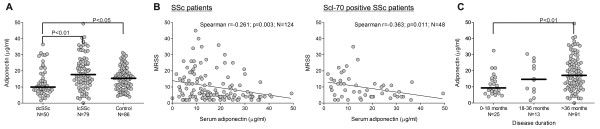
Serum adiponectin levels in systemic sclerosis (SSc). Sera from 129 patients with limited (lcSSc) or diffuse (dcSSc) cutaneous SSc and 86 controls were analyzed by multiplex assays. (a) Horizontal bars indicate median values in each group. (b) Correlation between adiponectin levels and modified Rodnan skin score (MRSS) in all patients with SSc (left panel) and patients with Scl-70-positive SSc (right panel). The solid line represents the linear regression line. (c) Adiponectin levels in patients with SSc according to disease duration (defined as duration from first non-Raynaud manifestation). Horizontal bars indicate median values.